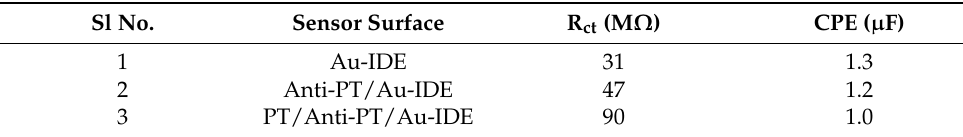
Table 1. Approximate values of interfacial parameters obtained from circuit simulation using Randel’s equivalent